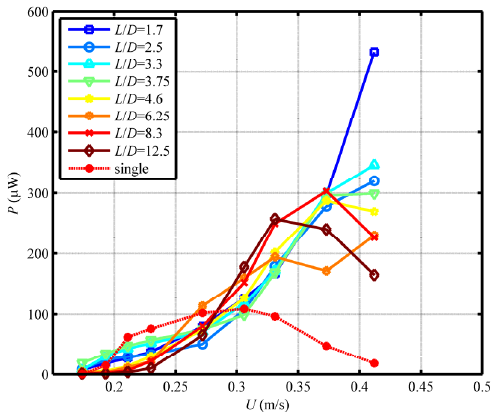
Figure 9. Output powers of the downstream harvester and the single one as a function of the water speed for eight different spacing ratios.